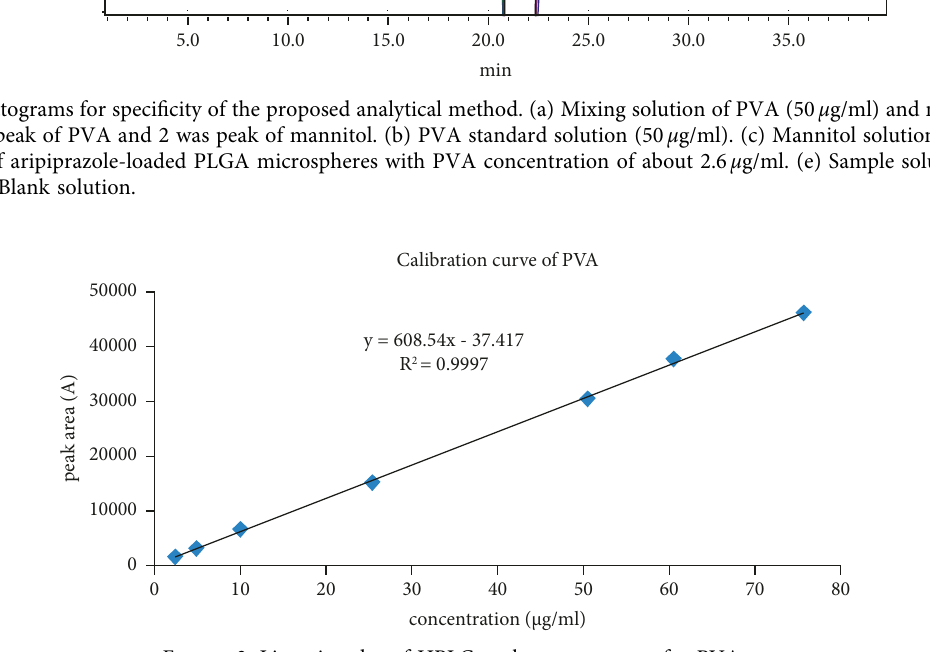
Figure 2: Linearity plot of HPLC peak area response for PVA. Table 3: Intraday precision and interday precision for determination of